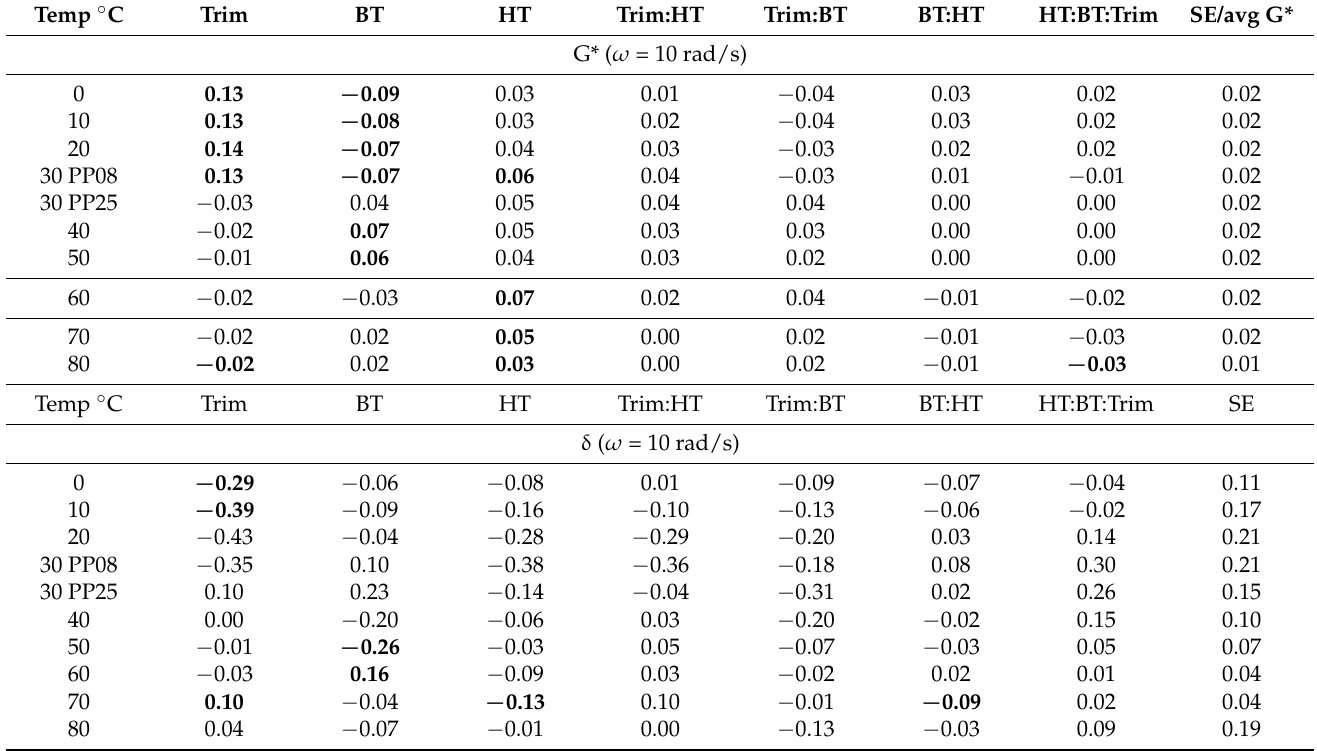
Table 6. Effect estimates and Standard Errors (SE) for 50/70. The significant effects with a 95% confidence interval are shown in bold.